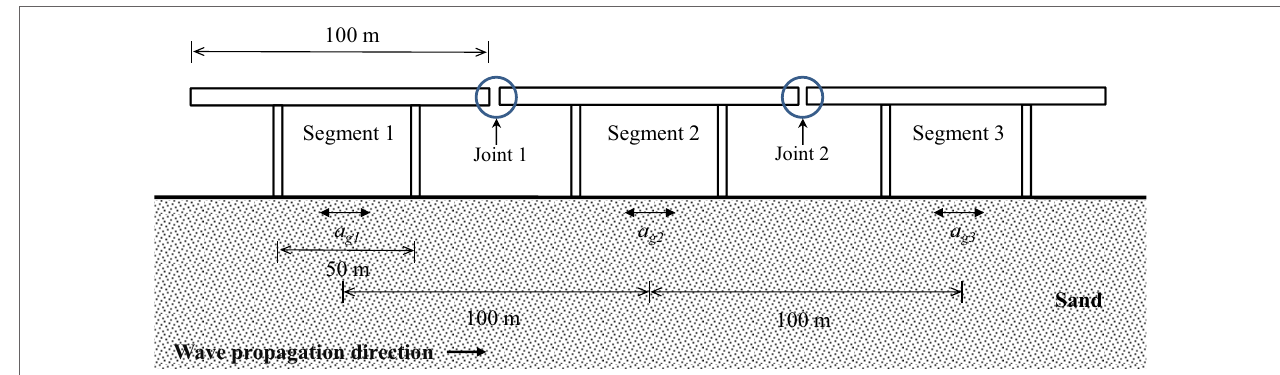
FigUre 2 | Prototype system with left to right seismic wave propagation